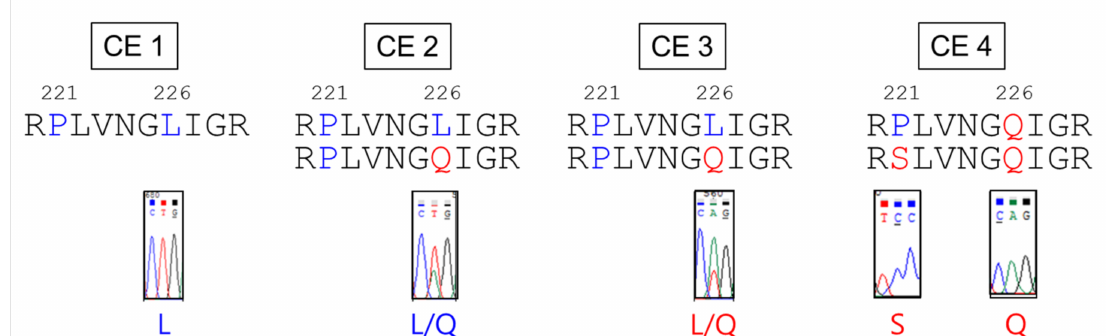
Figure 2. The six internal genes of 01310 induce reverse (L226Q) and additional (P221S) mutations in the HA of recombinant Egyptian H9N2 strains during ECEs passages. Recombinant Egypt H9N2 viruses with internal genes of 01310 were passaged to increase antigen yields in ECEs. All viruses showed increased replication efficiency in ECEs after the third passage by acquisition of the Q226L mutation in the HA protein, and rEgH9N2(310)-PB21U4 only had the additional P221S mutation in the HA protein after the fourth passage.